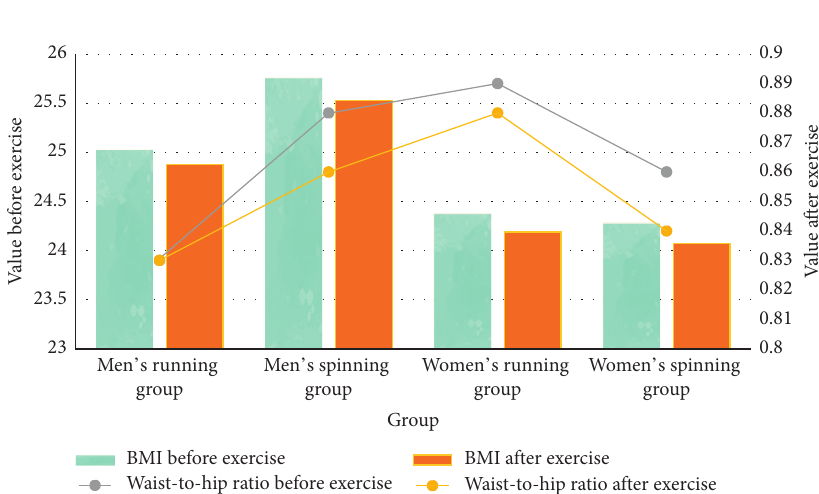
Figure 1: Comparison of BMI and waist-to-hip ratio of patients with dyslipidemia before and after exercise. Table 4: Changes in body composition of patients with dyslipidemia before and after exercise. Bone mineral content (kg) Group Before exercise